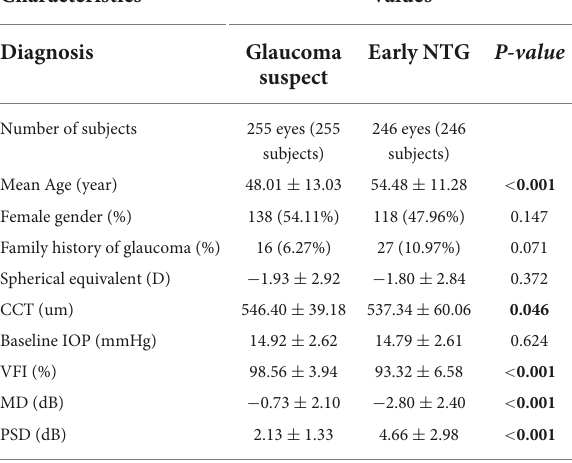
(dotted line) from 501 eyes (501 subjects) with either early NTG (246 subjects) or GS (255 subjects) were collected in a